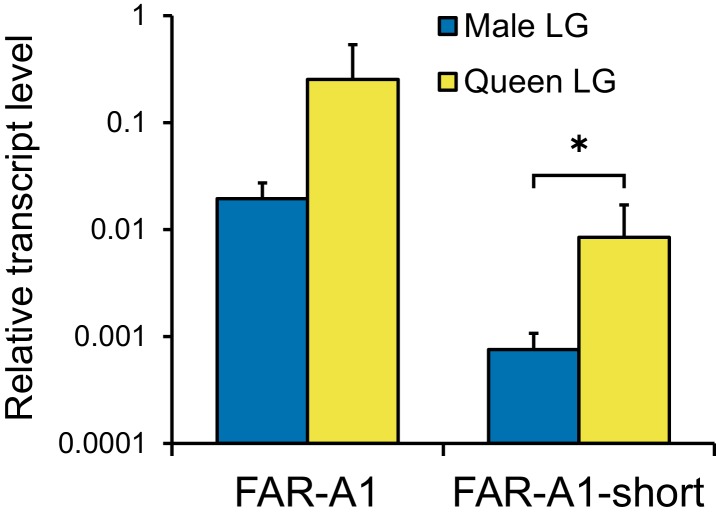
Relative expression of FAR-A1 and FAR-A1-short in male and queen LGs of B. lapidarius.The transcripts were determined in cDNA from tissues of 3-day-old B. lapidarius males and queens (N = 3; queen LG: one biological replicate represents tissues from two queens). Significant differences (p < 0.05, two-tailed t-test) are indicated with an asterisk.10.7554/eLife.39231.017Figure 4—figure supplement 2—source data 2.List of relative transcript level, Cp difference and Cp values for FAR-A1 and FAR-A1-short.The file contains a list of relative transcript level, Cp difference and individual Cp values for FAR-A1, FAR-A1-short and reference transcripts and the results of statistical testing.